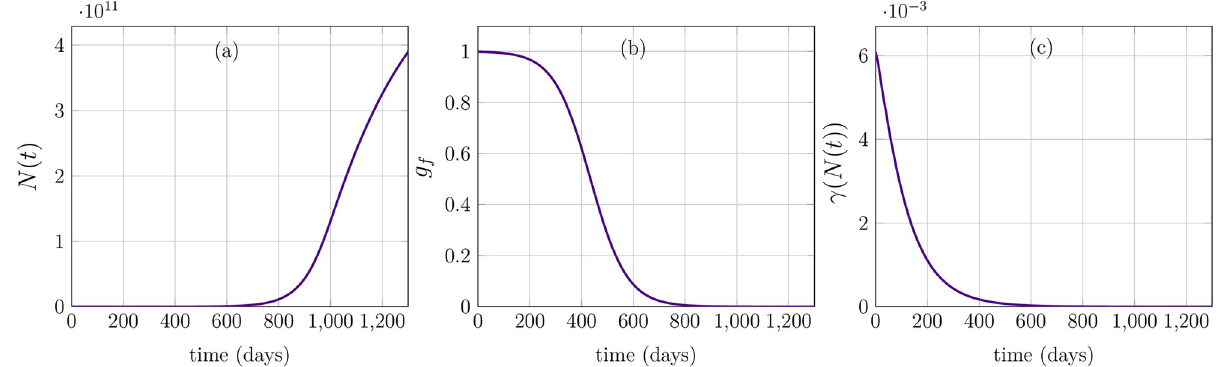
Fig 6. Unstable behavior. (a) Total cell population N ( t ) grows exponentially with time thus depicting an unstable behavior. (b) Growth-factors are increasing with rising total population of cells. However, as the change in N ( t ) larger and larger, the change in growth factors is negligible. (c) Gamma function is also declining.